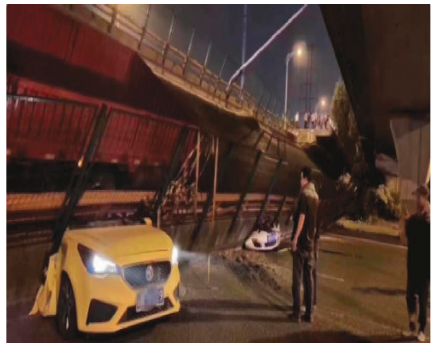
Figure 2: Rollover of viaduct in